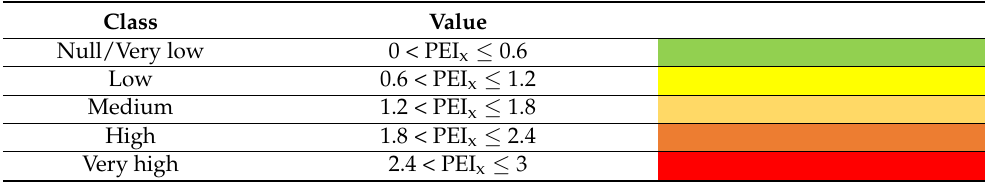
Table 2. The obtained five Physical Elements Index classes with colors—from green to red—indicating an increase of proneness to